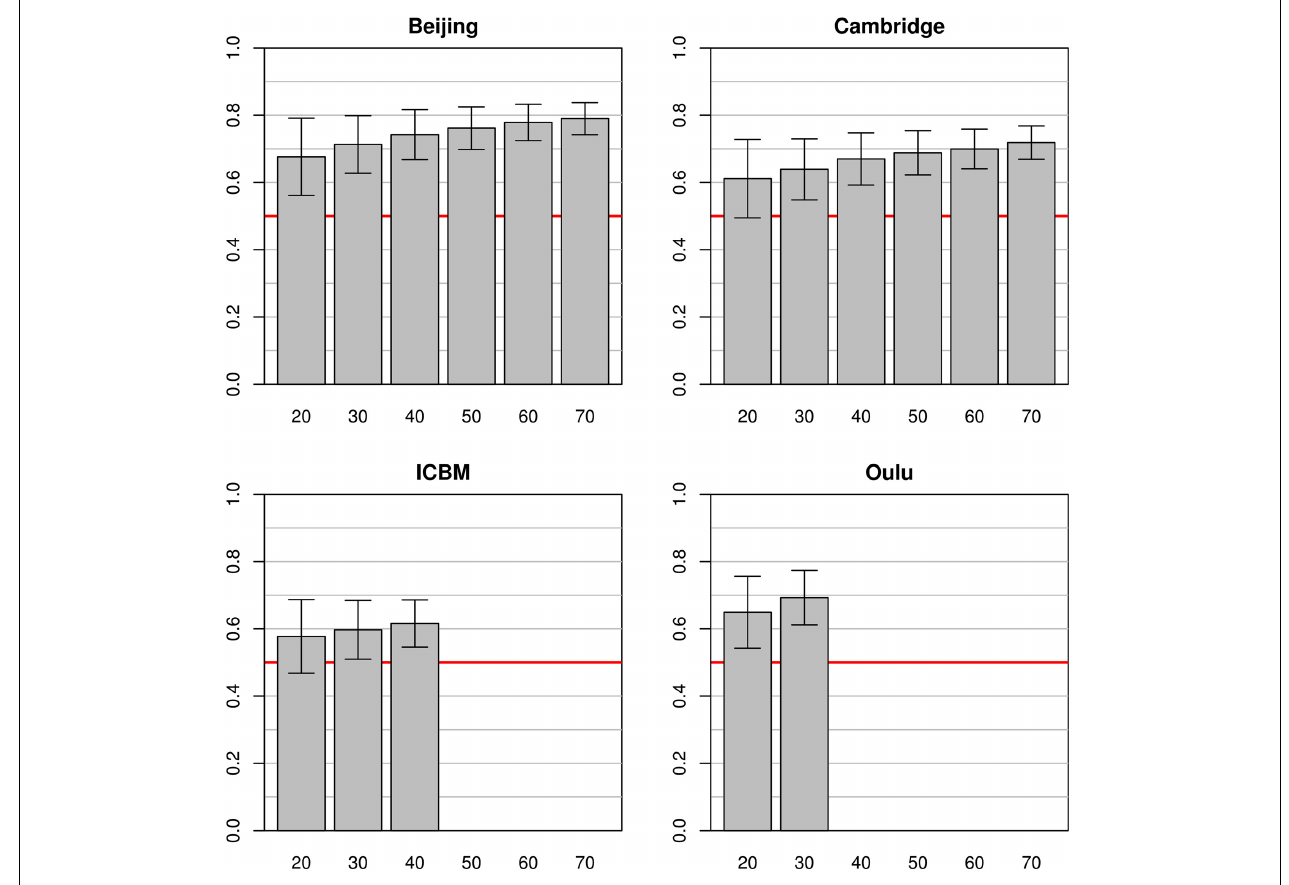
FIGURE 2 | Simulations using equally sized test and training datasets from the same study. Each bar represents the mean test accuracy for a particular sample size (which was used for